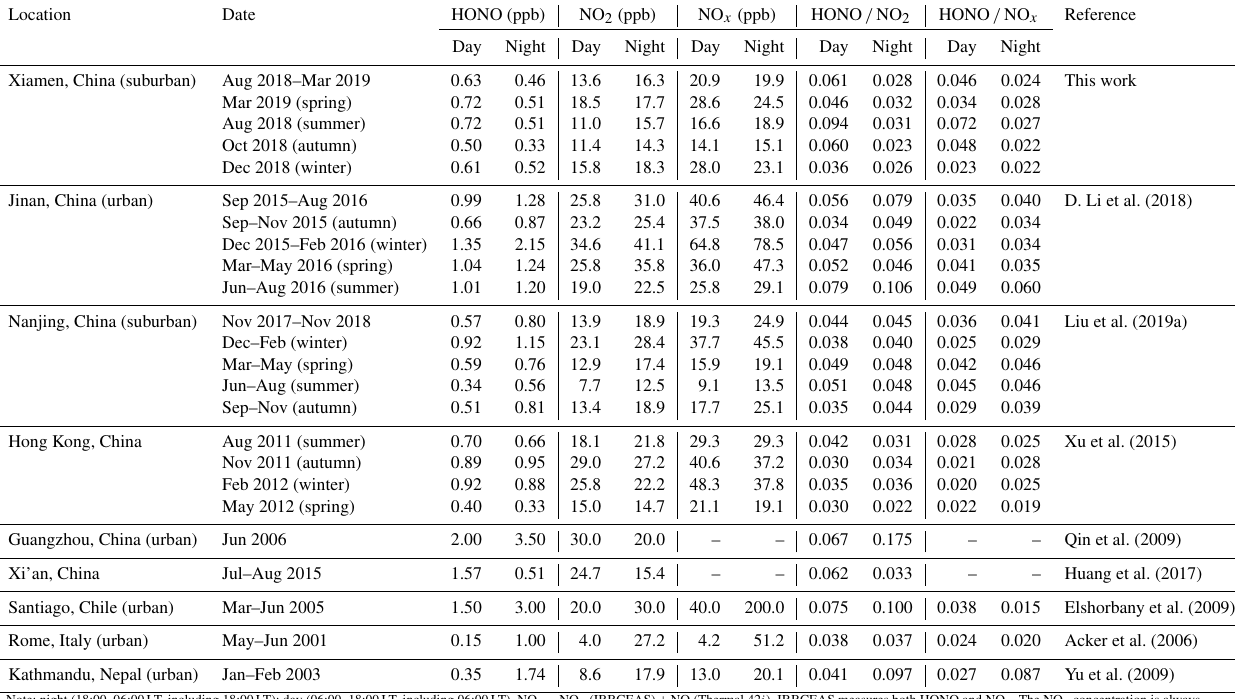
Table 1. Overview of the HONO and NO x average concentrations measured in Xiamen and comparison with other measurements.